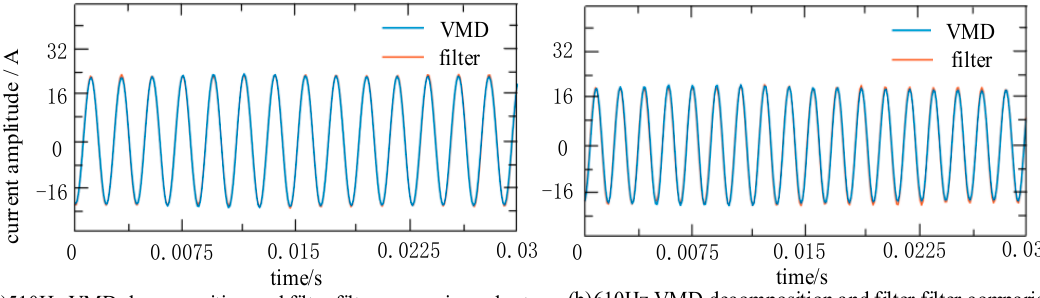
Figure 13. VMD modal decomposition of each modal waveform and fi lter waveform comparison.